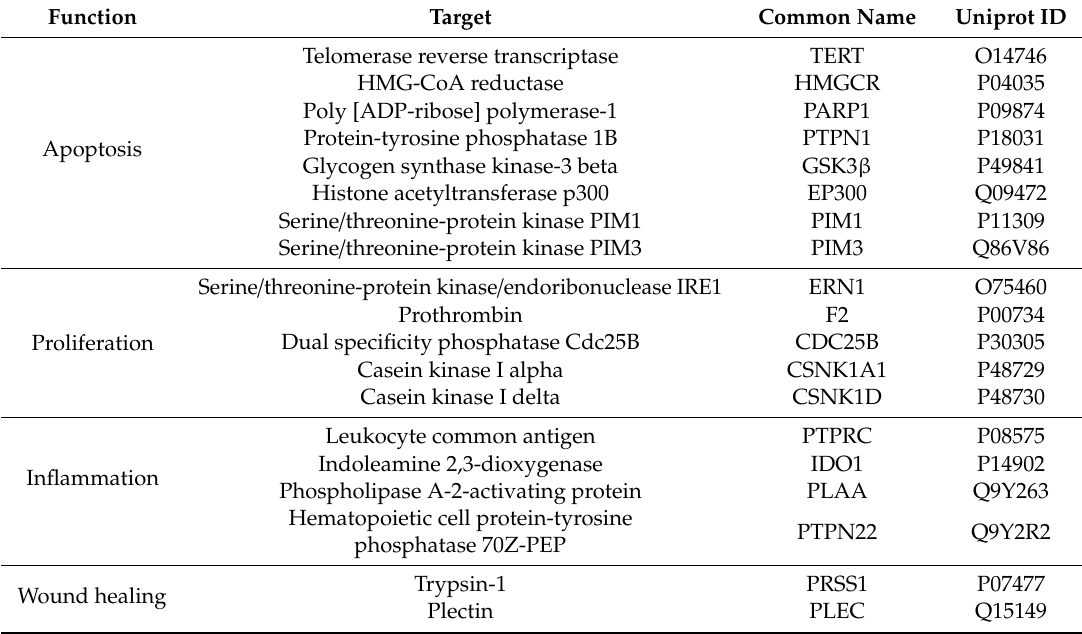
Table 1. Information of Targets of Ecdysterone and Paeonol.